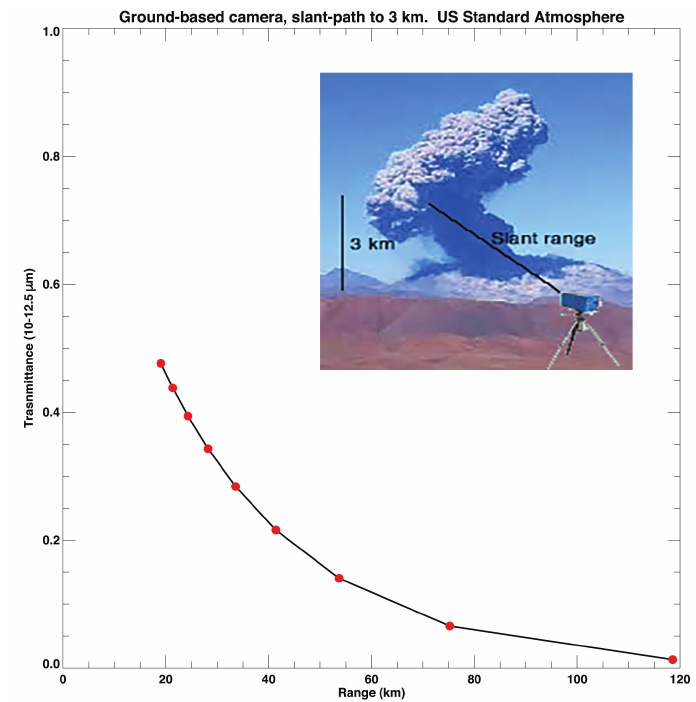
Figure 3. Transmission as a function of path distance for a thermal IR imager sensing from the ground along a slant path to an object–in this case a volcanic plume. Beyond 60 km the transmission falls below 10% making imaging the plume extremely